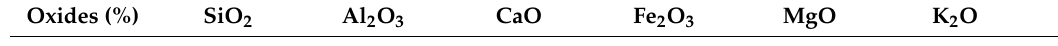
Table 2. Oxide composition of TZ clay.